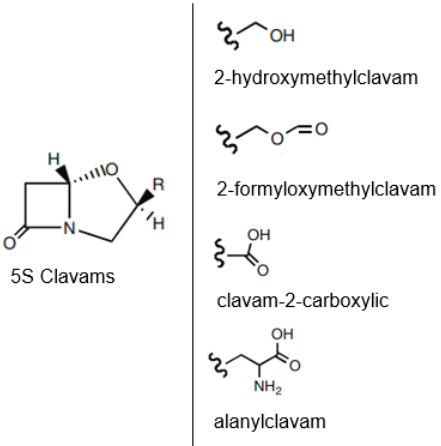
Figure 3. Chemical structure of 5S clavam compounds obtained from Streptomyces clavuligerus. (Adapted from Nobary and Jensen [61]).